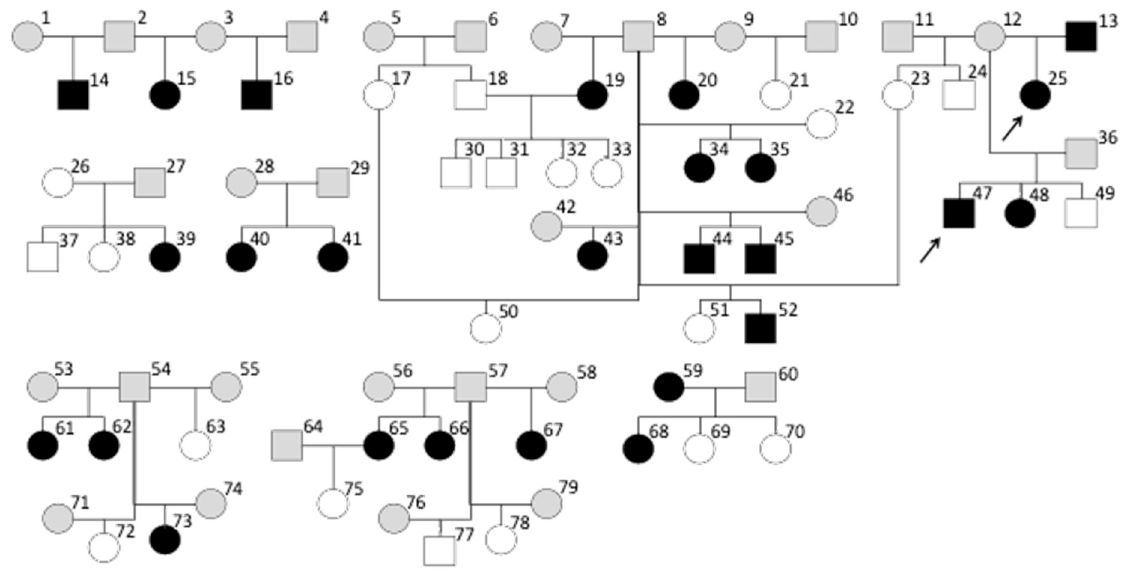
Figure 2. Pedigree lines of 50 Labrador retrievers and their ancestors illustrated by family trees. There is one family (parents #18 and #19 with an offspring #30–33) whose members all underwent an echocardiogram. Dog #18 was a male without mitral regurgitation, while dog #19 was a female with mitral valve regurgitation. None of their puppies had a mitral valve regurgitation. When assuming that a mitral valve regurgitation trait depends on a monogenetic inheritance, the absence of mitral valve regurgitation in the four dogs of this litter raises the suspicion of an autosomal recessive inheritance. Aortic valve regurgitation was documented in dogs #25 and #47 (arrows). They had a common parent (dog #12). Circle = female; square = male; black = mitral valve regurgitation present; white = mitral valve regurgitation absent; gray = presence of mitral valve regurgitation is unknown; arrow = aortic valve regurgitation